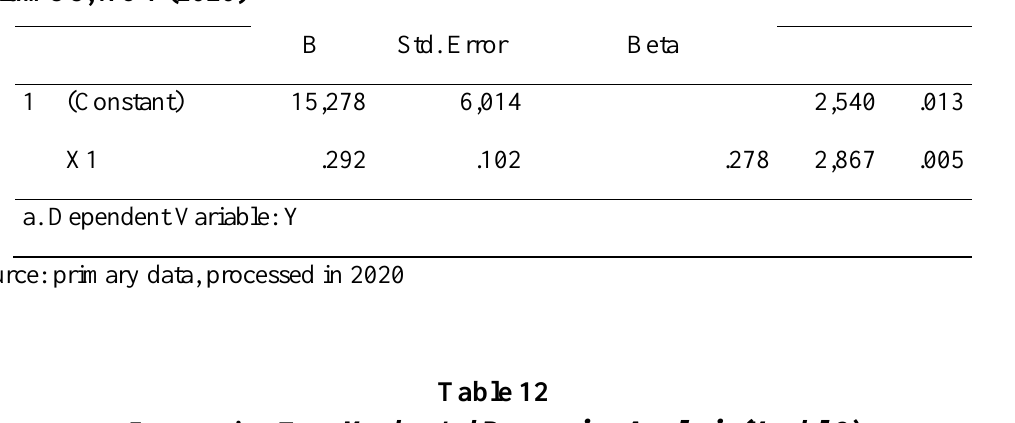
Interaction Test Modereted Regression Analysis (Model